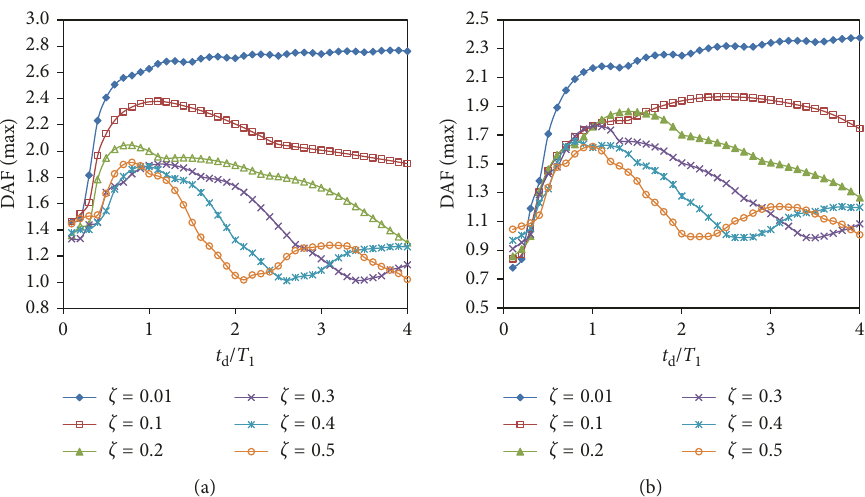
Figure 7: DAF (max) curves of shear force of bridge columns under impact load at midspan with different slopes of load growth. (a) F-F. (b) F-H.